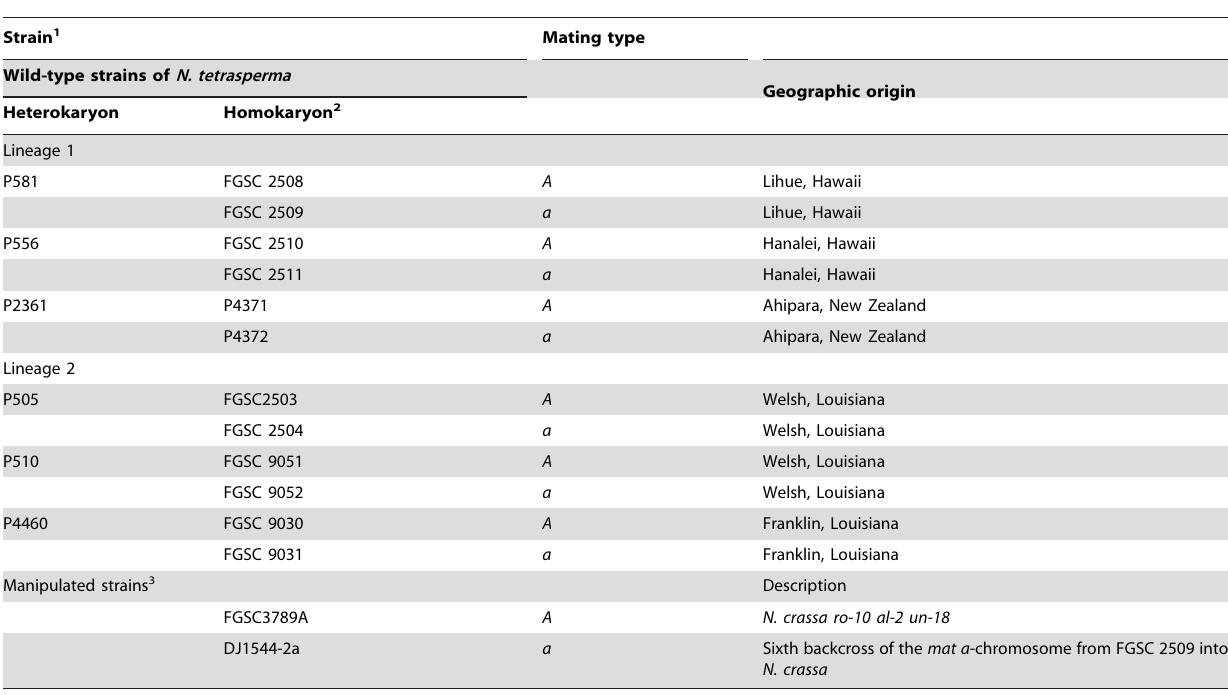
Table 1. Fungal Material of N. tetrasperma and N. crassa used in the Study.